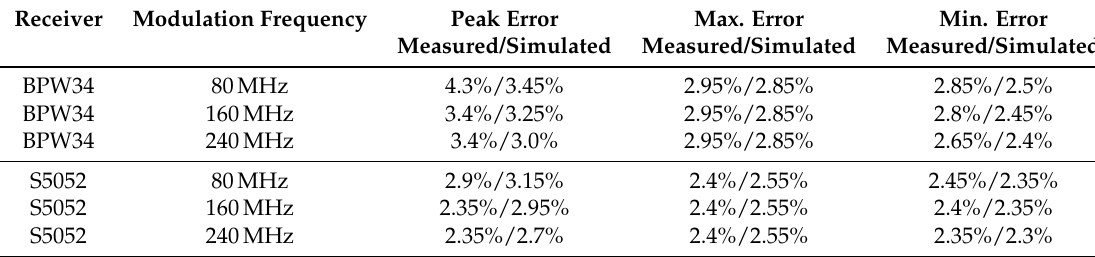
Table 2. Measured and simulated relative